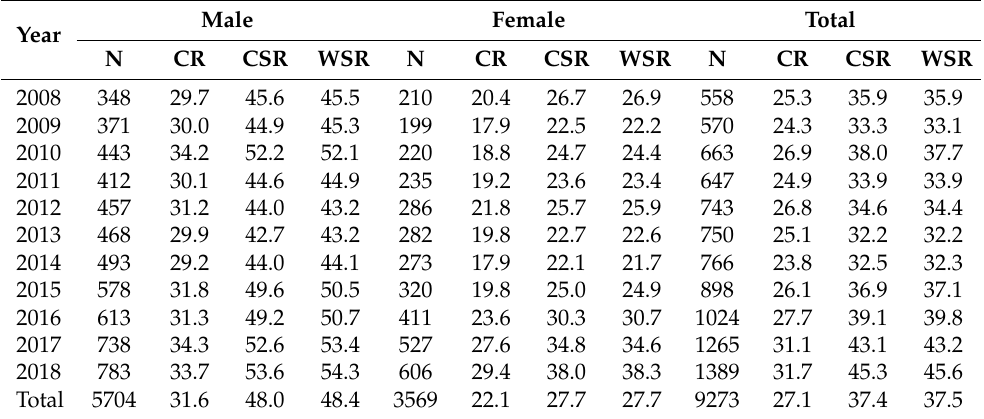
Table 1. The incidence of lung cancer by sex in Shenzhen, 2008–2018 (1/100,000).